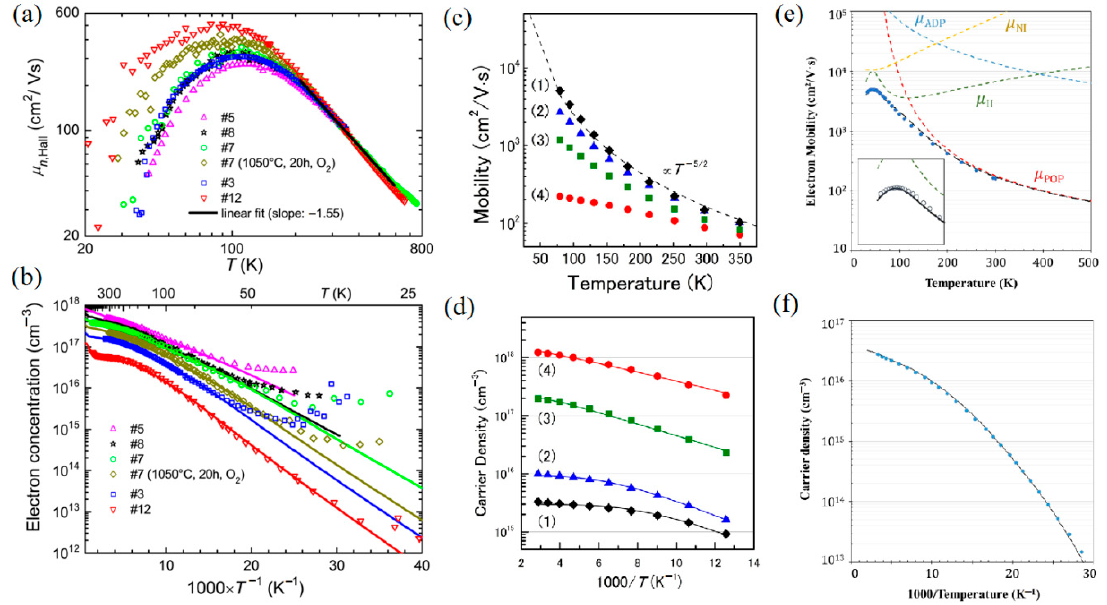
Figure 4. ( a ) The Hall mobility and ( b ) electron density as functions as the temperature for β -Ga 2 O 3 single crystals grown by the Czochralski method [58]. Copyright 2011 American Institute of Physics. ( c ) The Hall mobility and ( d ) electron density as functions as the temperature for Si-doped homoepitaxial films grown on β -Ga 2 O 3 (001) substrate by halide vapor-phase epitaxy [60]. Copyright 2018 Elsevier. ( e ) The Hall mobility and ( f ) electron density as functions as the temperature for silicon- doped β -Ga 2 O 3 homoepitaxial films grown on β -Ga 2 O 3 (010)-oriented substrates via metalorganic chemical vapor deposition [56]. Copyright 2019 American Institute of Physics. Table 2. Basic electric properties of β‐ Ga 2 O 3 [32,61].